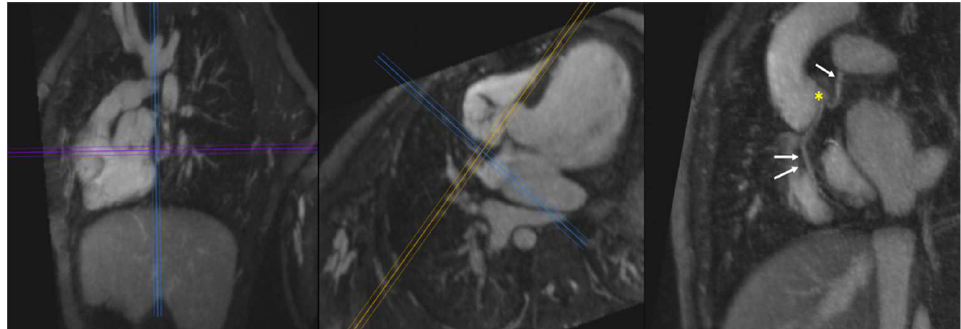
Figure 11. Single Coronary Artery. A single coronary artery is seen arising from the left aortic sinus in this young child with surgically repaired double outlet right ventricle and atrioventricular canal defect. Multiplanar maximum intensity projections from a 4D FE-MRA (MUSIC) study show the common origin of the right (double arrow) and left coronary (single arrow) arteries from the posterior aspect of the left aortic sinus (yellow asterisk).